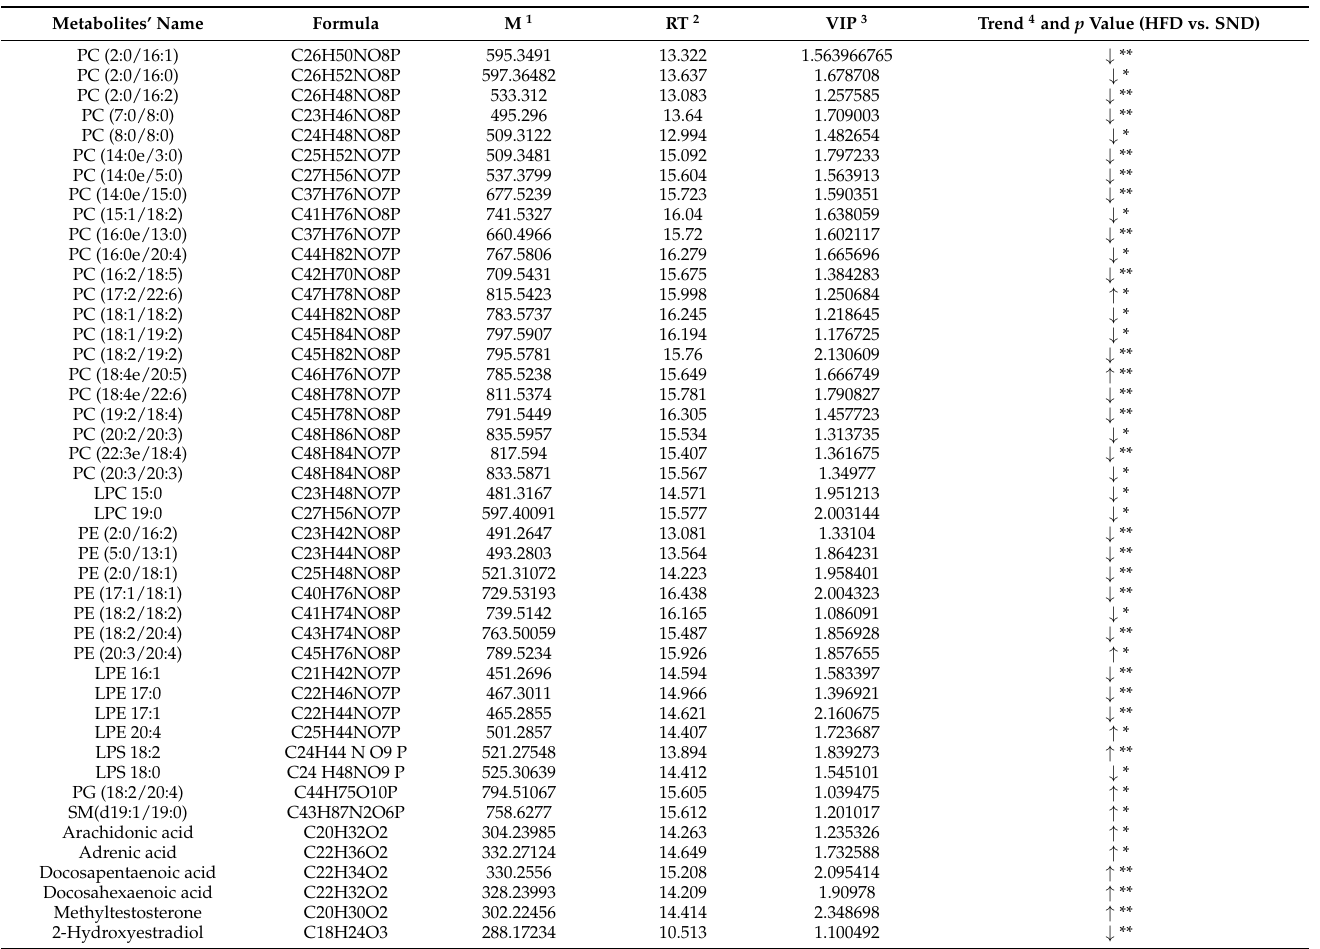
Table 1. Metabolites with significant difference were analyzed by LC-MS/MS to identify potential biomarkers of interest. Metabolites’